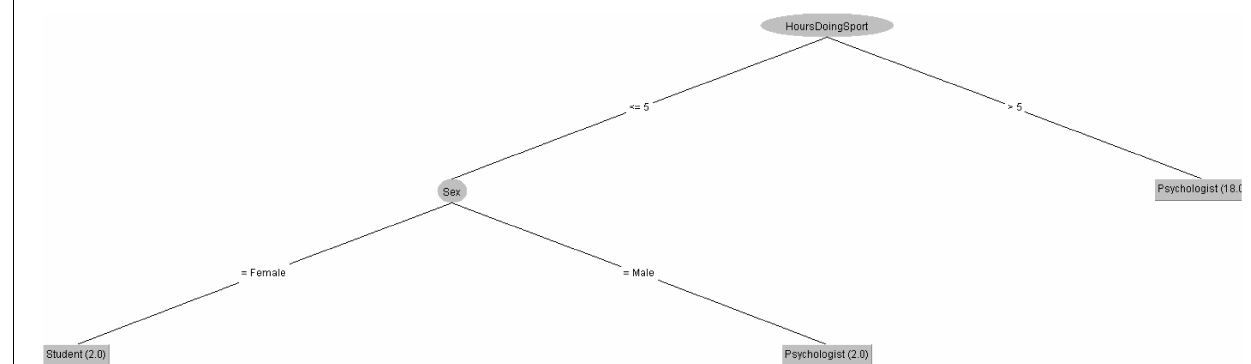
FIGURE 11 | Profession of people taking the RS questionnaire in 2019 decision tree.